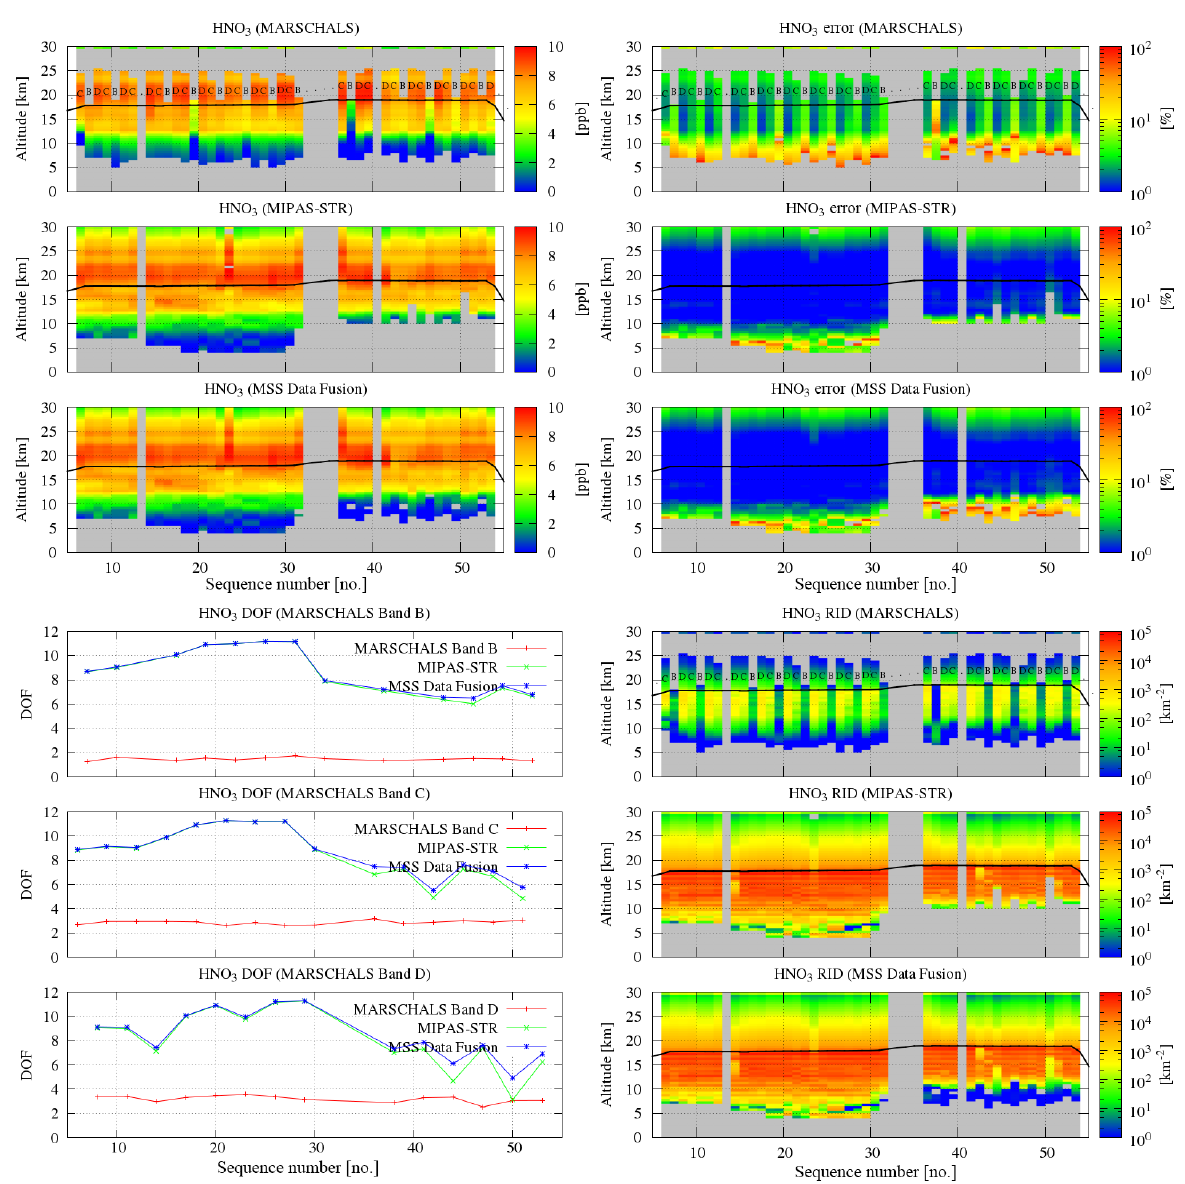
Figure 6. HNO 3 retrieved results obtained from MSS individual analysis and MSS data fusion of MARSCHALS and MIPAS-STR limb sounding observations: vertical profiles (top left panel), total relative error profiles (top right panel), number of DOF (bottom left panel) and RID profiles (bottom right